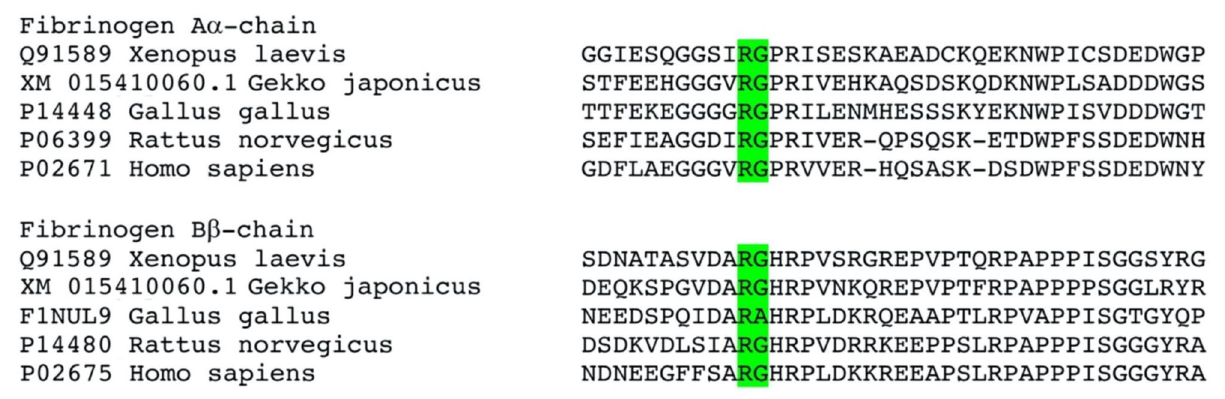
FIGURE 13 | Sequence alignment of the activation cleavage sites. Cleavage site of normal thrombin is shown in green, however the venom induced cleavage sites remain to be elucidated for these venoms. There are however clear sequence differences downstream of the known thrombin cleavage site that are distinct between mammals and